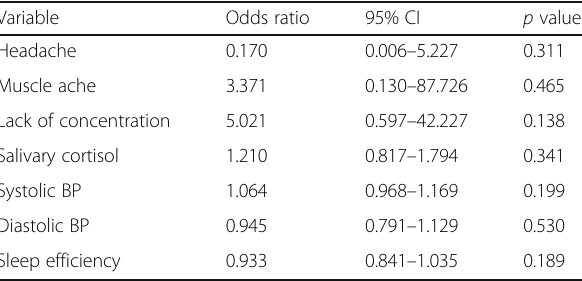
Table 5 Logistic regression of the predictors of shift work sleep disorder among the shift subjects